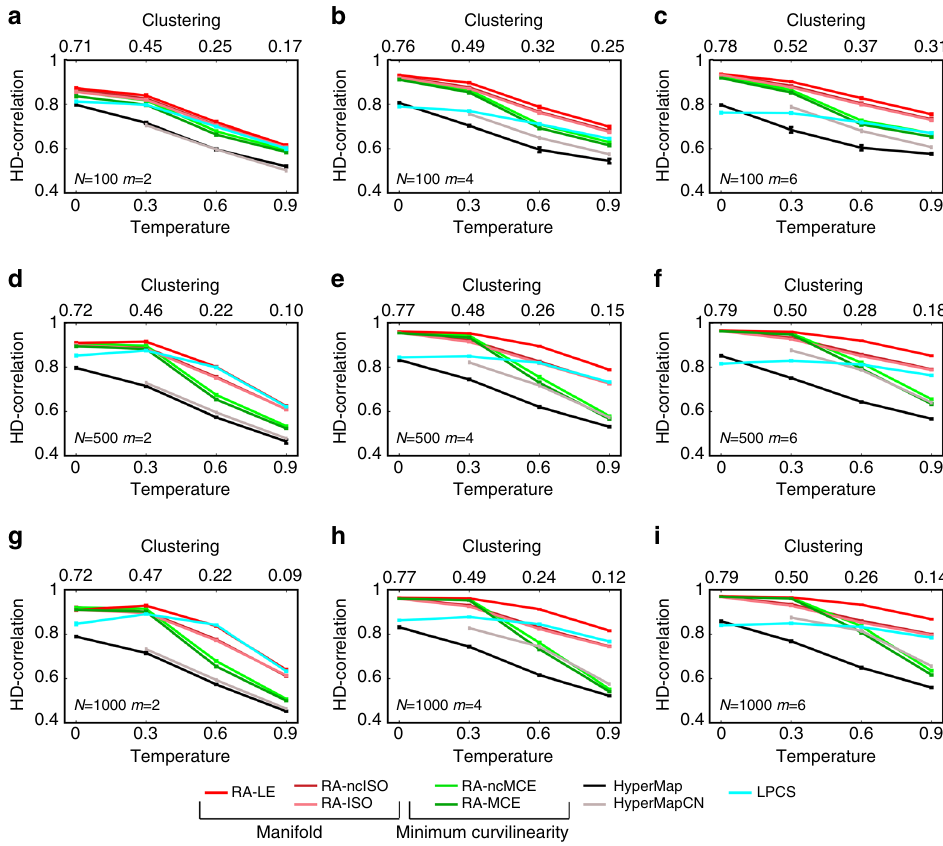
Fig. 3 HD-correlation on popularity-similarity-optimization synthetic networks. a – i To validate the above-mentioned techniques, we generated 100 different synthetic networks for each combination of tuneable parameters of the PSO model (temperature T , size N , half of average degree m , power-law